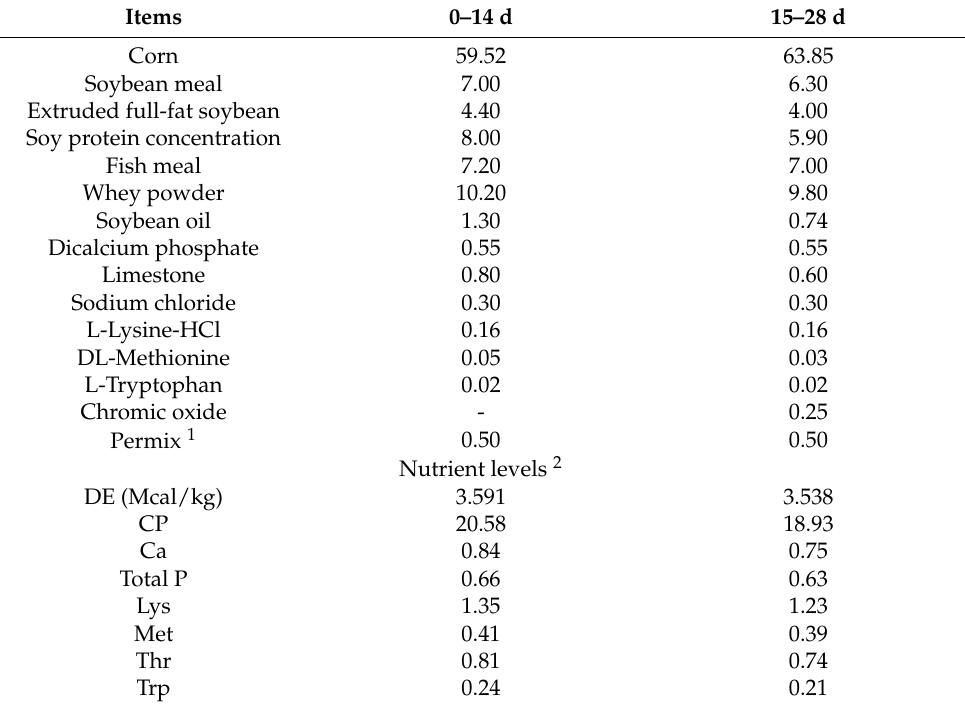
Table 1. Ingredient composition and nutrient content of the basal diet (as-fed basis, %).